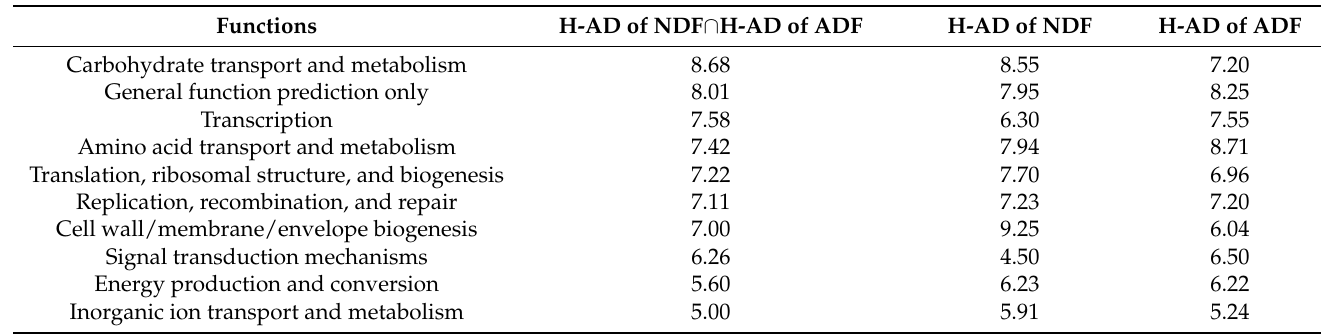
Table 3. The proportion of each group in the top 10 function abundance (%).